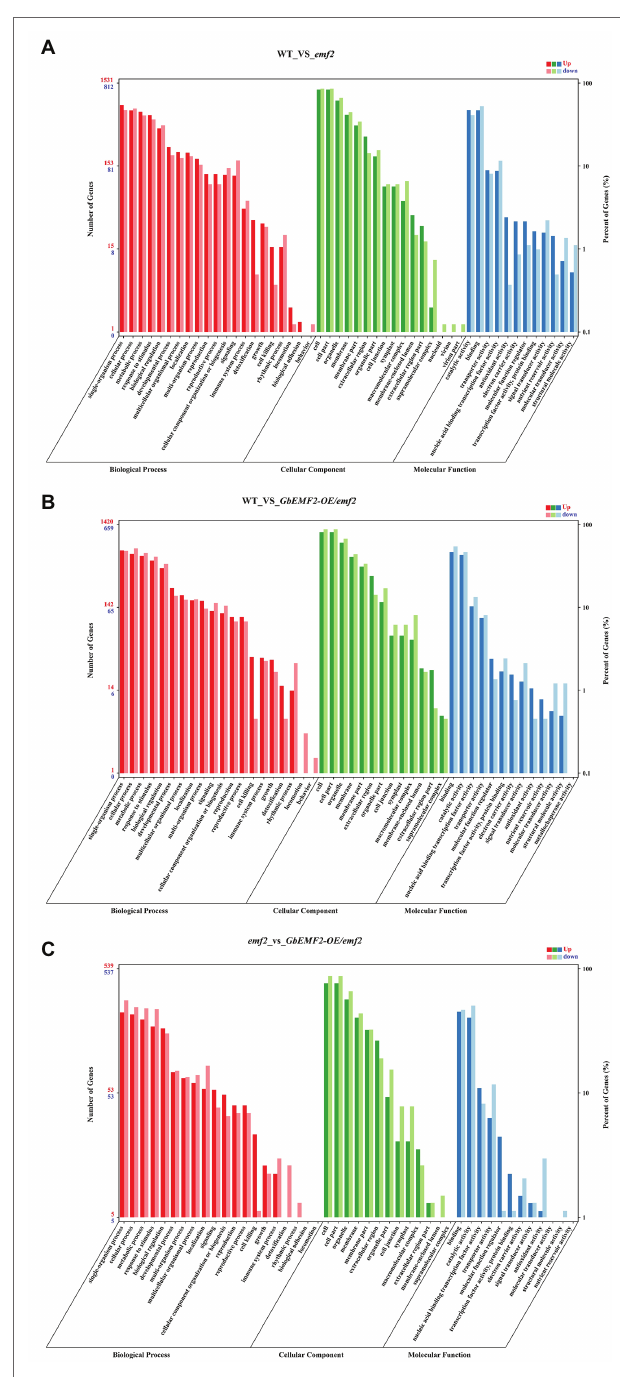
FIGURE 5 | Gene ontology (GO) of differentially expressed genes (DEGs) analysis of WT, emf2 mutant, and GbEMF2-OE/emf2 plant. A total of 3,414 DEGs were annotated by at least one of the three categories: biological process, cellular component, and molecular function. (A) The GO classification of WT _ vs _ GbEMF2-OE / emf2 . (B) The GO classification of WT _ vs _ e mf2 . (C) The GO classification of e mf2 vs _ GbEMF2-OE / emf2 . The x -axis indicates the level 2 GO terms, and the double y -axis means the number of genes and percentage. Red, green, and blue represent upregulated of biological process, cellular component, and molecular function, respectively. Dark red, dark green, and dark blue represent downregulated of biological process, cellular component, and molecular function,